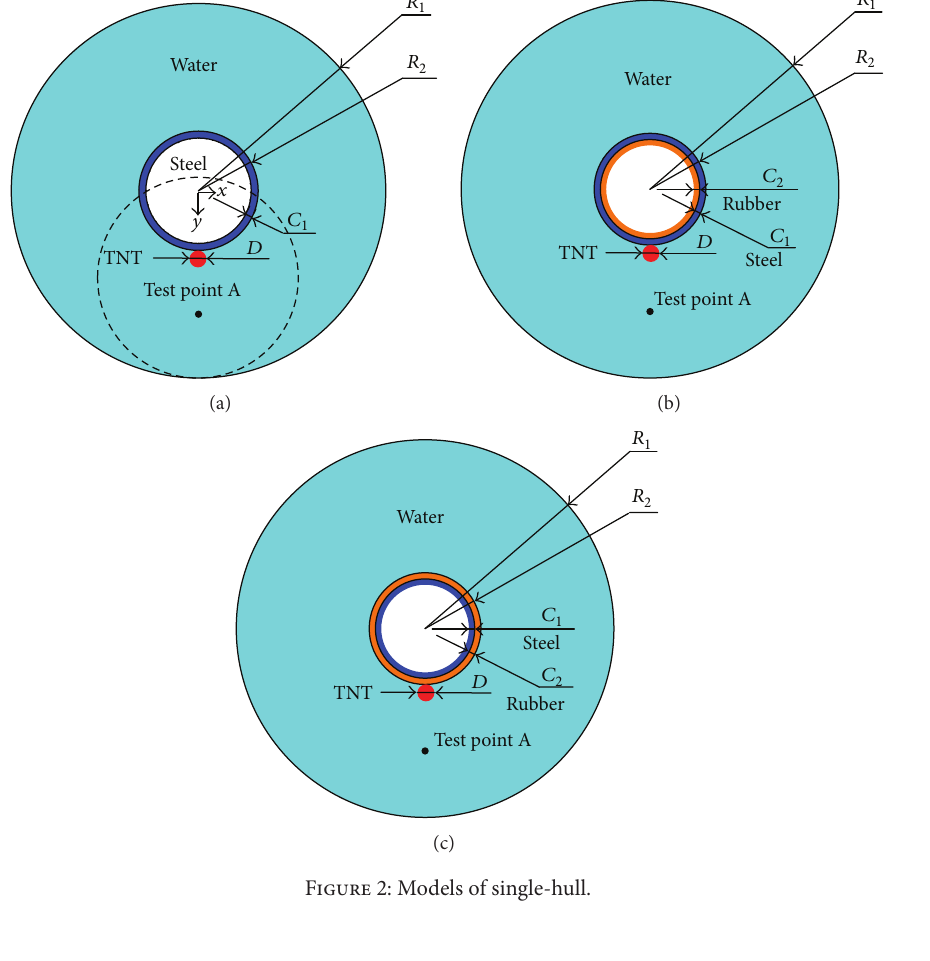
Figure 2: Models of single-hull.